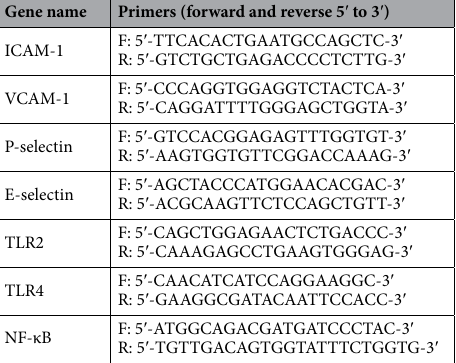
Table 1. Sequences of primers used for quantitative RT-PCR in